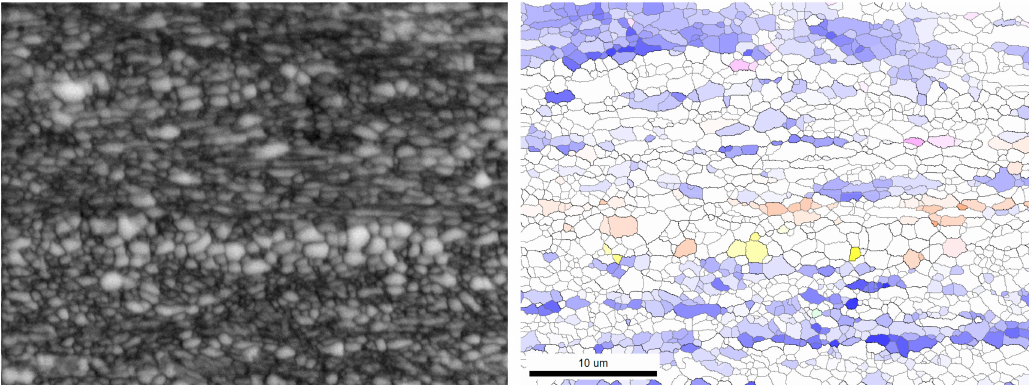
Figure 1. Image quality map ( left ) and reconstructed orientation map with fully closed high- and low-angle boundaries ( right ). This particular example is from high purity aluminium (HP Al) annealed for 100 s at 220 ◦ C. The colours refer to specific texture components, according to the colour coding given in Figure